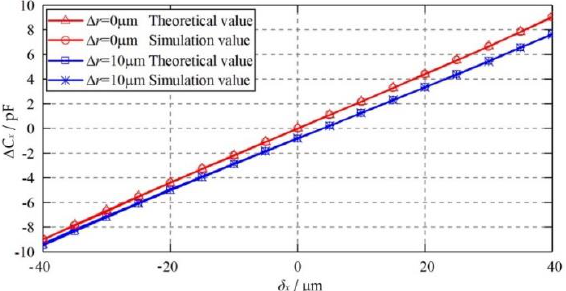
Figure 11. Dependence of the differential capacitance Δ C x on the eccentric displacement of the ball when the plate becomes an ellipsoid.